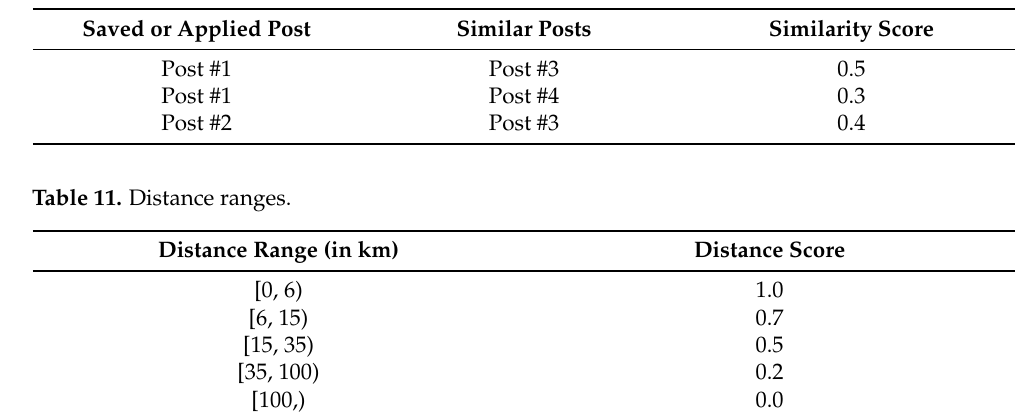
Figure 15. CQ_08: Which job posts are similar to posts that the migrant has applied for or saved as a favorite? Table 10. Similarity combinations.